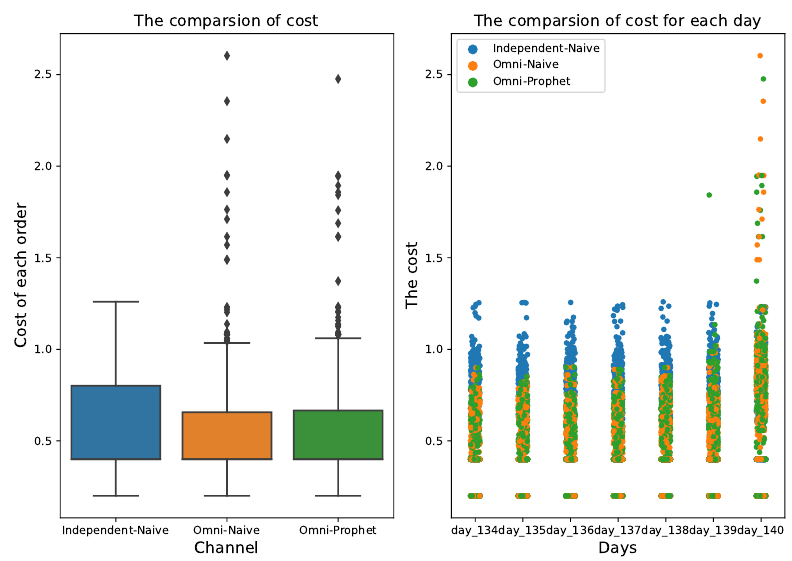
Figure 10. Cost comparison in the scenario with increasing